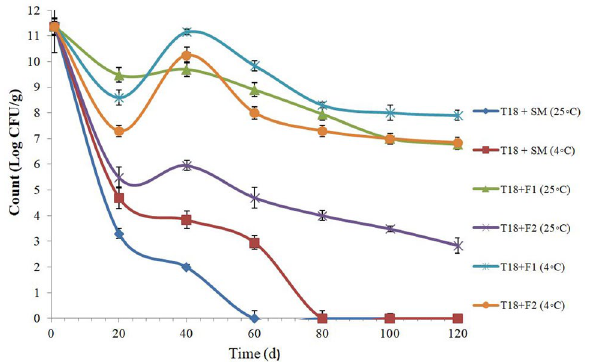
Figure 2. Storage stability of lyophilized and covered T18 probiotic strain with different Tarkhineh formulations during 120 days storage at 25 °C and 4 °C. T18: Lactococcus lactis T18. F1: plain Tarkhineh. F2: turmeric Tarkhineh. SM: 10% skim milk + 5% sucrose. Values shown are means ± standard deviations (n =